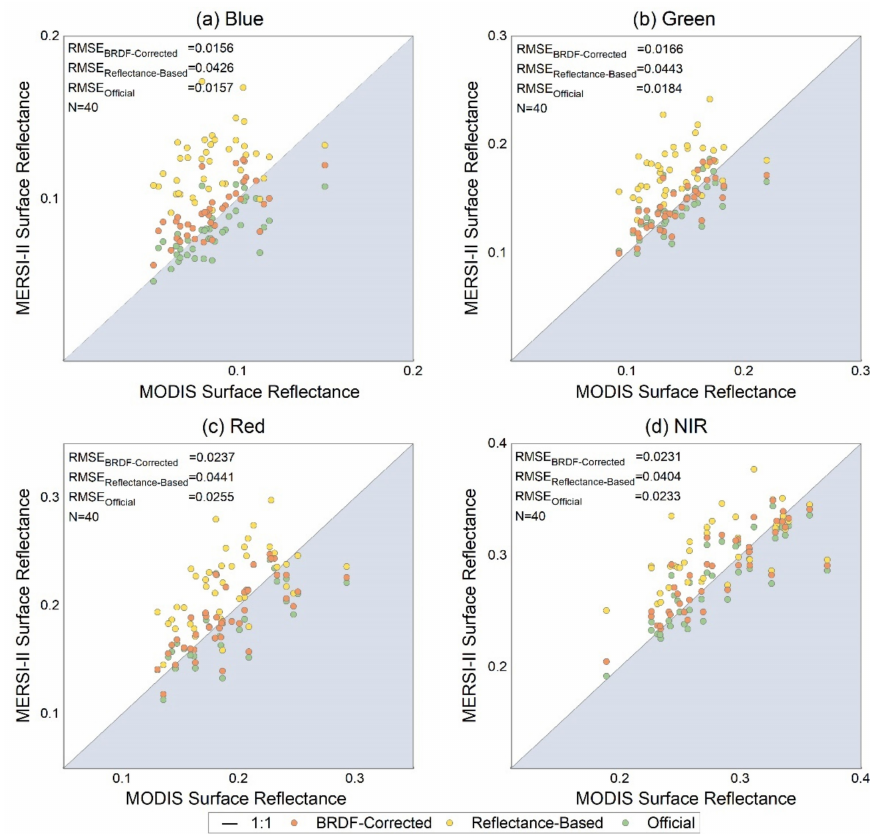
Figure 10. Validation of calibrated surface reflectance of FY-3D MERSI-II using simulated surface reflectance from MODIS observations for the four spectral bands: ( a ) blue band; ( b ) green band; ( c ) red band; ( d ) NIR band. The results of the three versions of calibration coefficients are plotted in this figure. The statistical results of RMSE and number of samples are also provided.